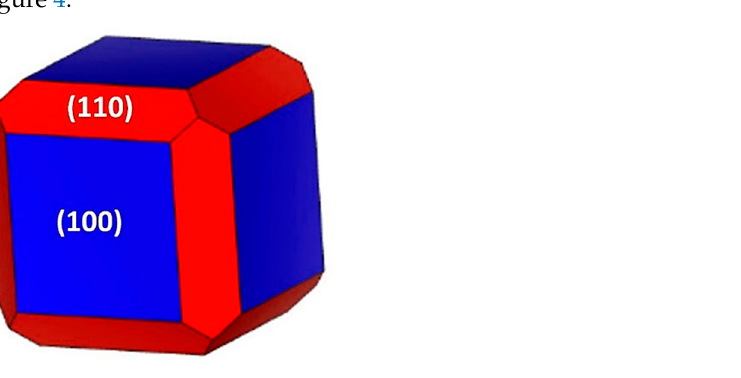
Figure 4. Wulff construction proposal for the shape of PbTe nanoparticles after using TBP as a PCA during milling.